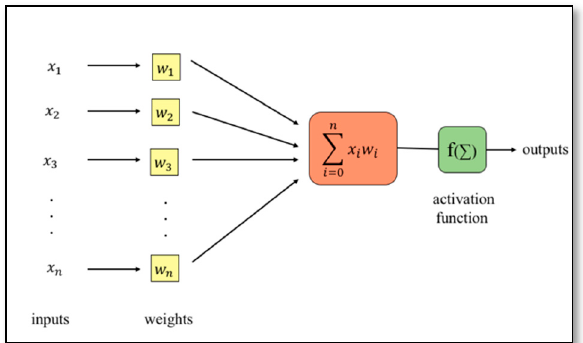
Figure 5. Structure of neural networks with activation function.